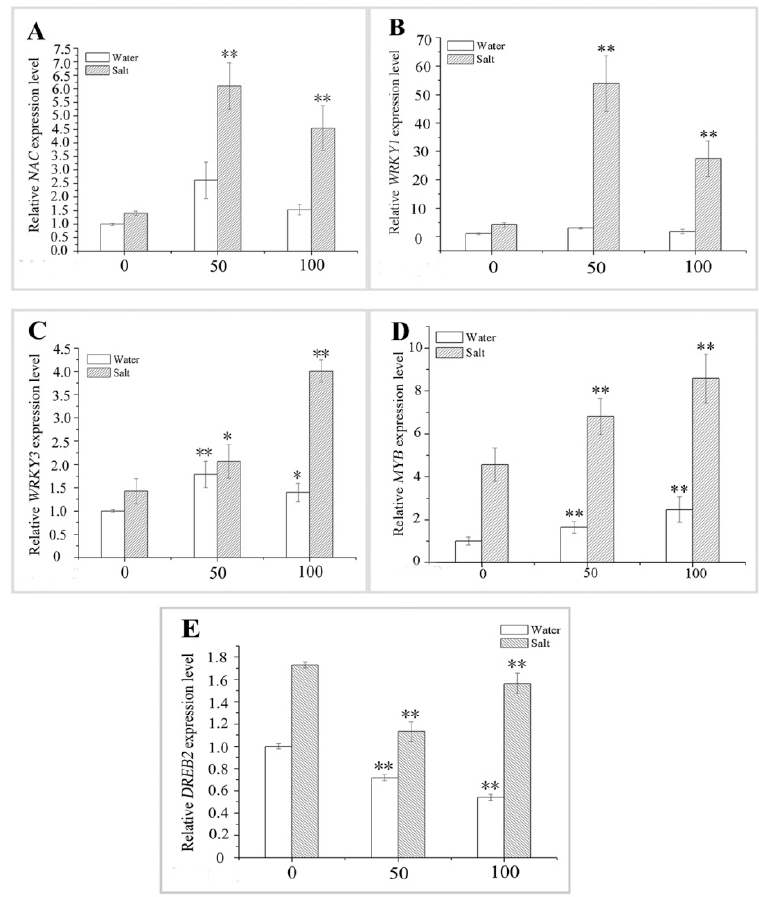
Figure 9. Effect of pretreating with different concentrations of melatonin (MT) on the expression of antioxidant-related transcription factors (TFs) genes in leaves of naked oat seedlings under salt stress. The relative expression of the related TFs genes NAC ( A ); WRKY1 ( B ); WRKY3 ( C ); MYB ( D ); and DREB2 ( E ). Values are mean ± standard deviation ( n = 3). 0, 50, and 100 represent MT concentration ( µ M) in Figure 9. Asterisks; * and ** indicate significant difference ( p < 0.05 and p < 0.01) compared with mock coating (0 µ M). Measurement was carried out after six days of the salt plus MT pretreatmemt.